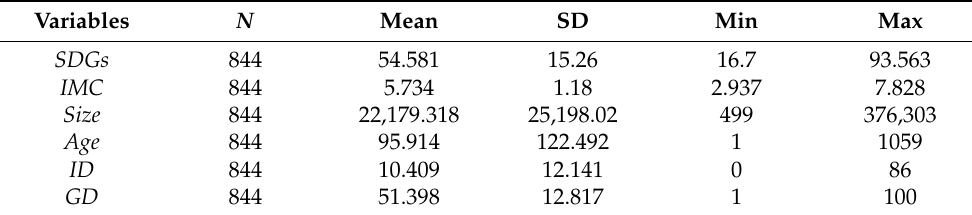
Table 5. Descriptive statistics.